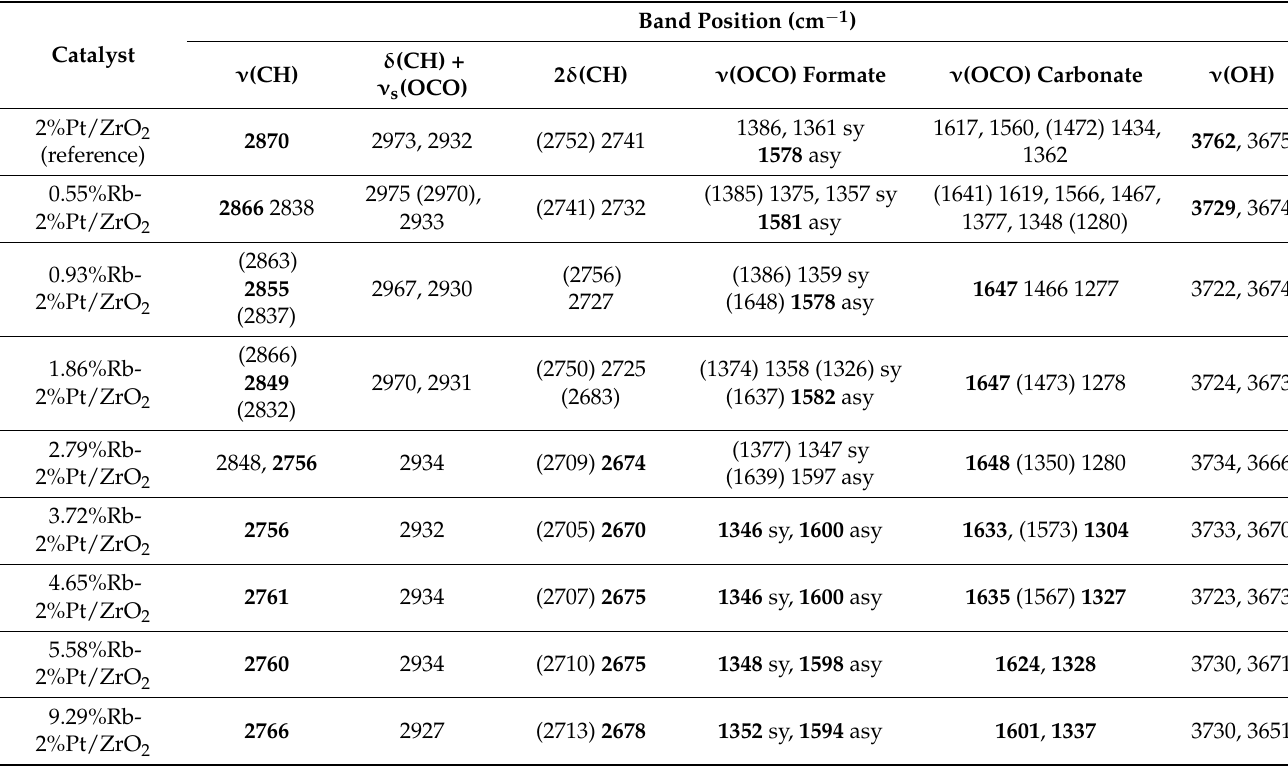
Table 3. Formate ν (CH) band region positions upon CO adsorption using the assignments of Binet et al. [51]. Bold indicates strong bands while shoulders and weak bands are included in